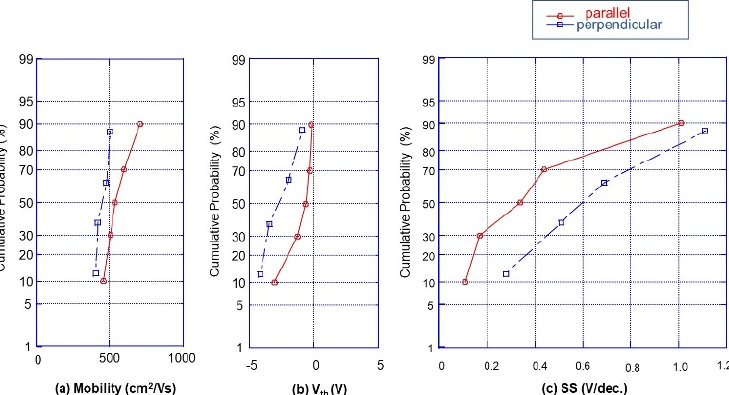
Figure 13. Cumulative distributions of the electrical characteristics in the grained CLC for the parallel and perpendicular TFTs. ( a ) Effective field-effect mobility, ( b ) threshold voltage Vth , and ( c ) subthreshold swing SS .